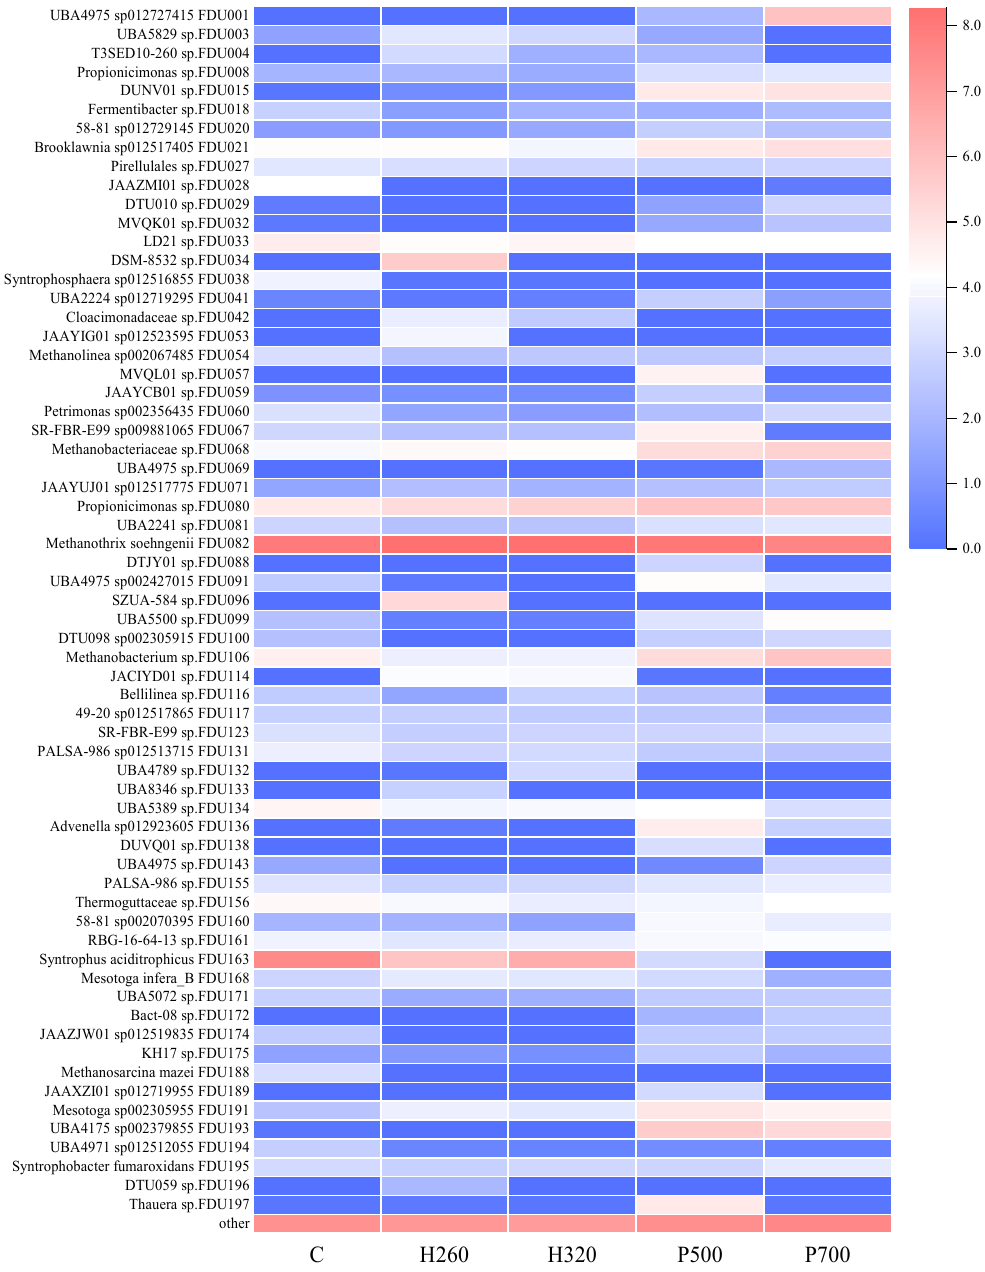
Figure 4. The abundances of GBs in all the samples. “Others” includes all the GBs that have abun- dances less than 5. The values in the legend were the log2 transformation of